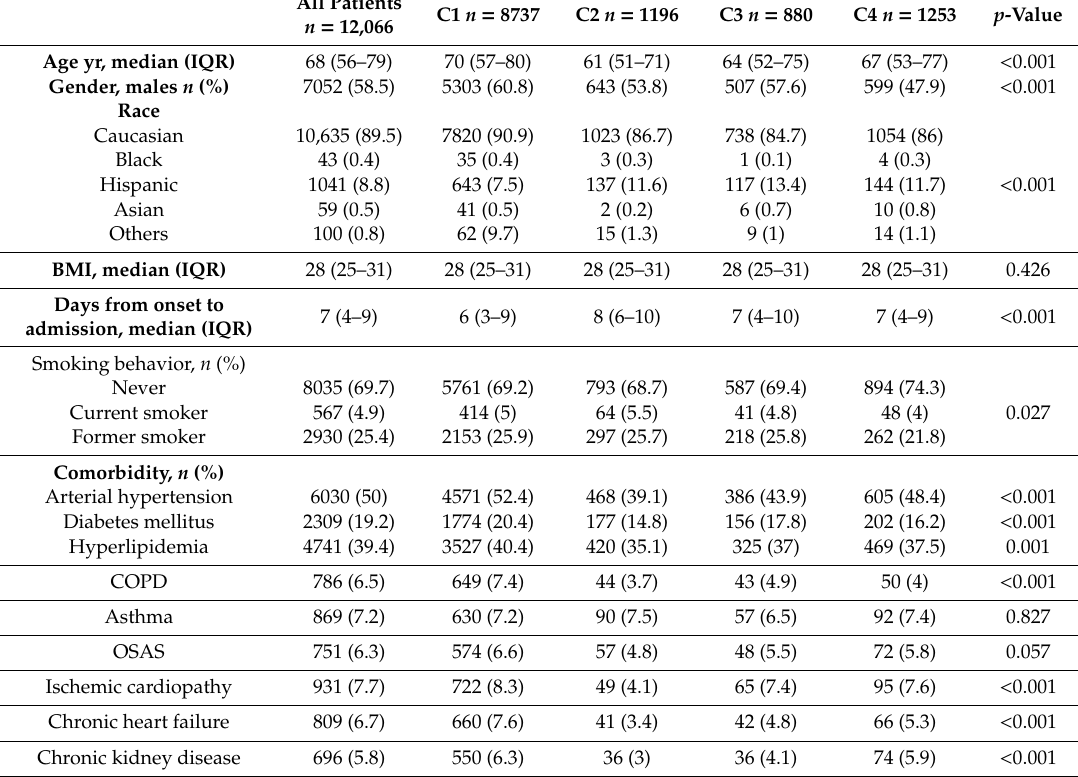
Table 3. General data and lab tests between clusters.